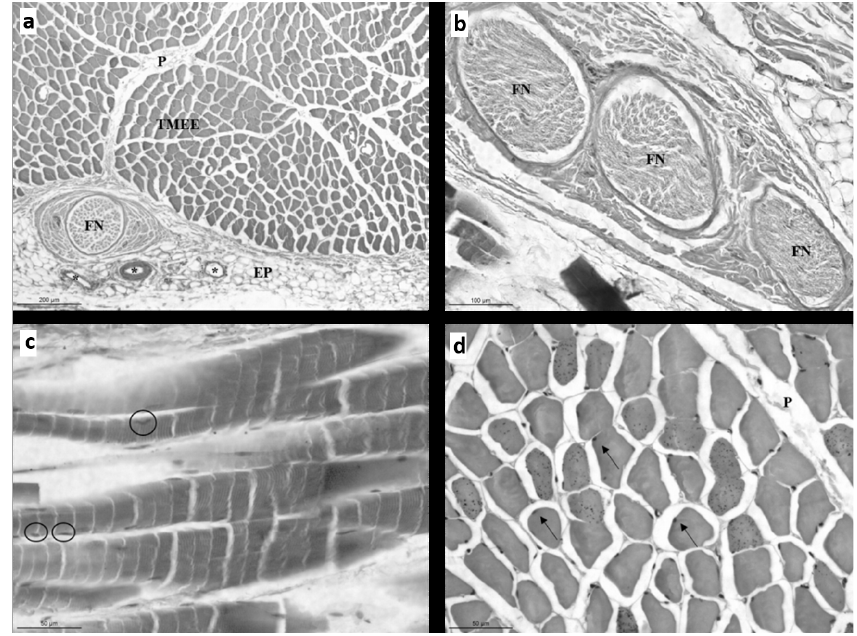
Figure 3 - Photomicroscopy of the diaphragm of Southern Tamandua. a: Overview of the organ composed by skeletal striated muscle tissue (TMEE) and covered by the epimysium (EP). Notice invaginations of connective tissue (P), portion of nervous bundle (FN) and vascularization (*). Gömöri trichrome stain. Scale bar 200 µm. b: nervous bundle (FN), composed of 3 nerve fibers. H&E stain. Scale bar 100 µm. c: Myocytes in longitudinal cut. Notice the stratifications and peripheral nucleus (circles). H&E stain. Scale bar 50 µm. d: Myocytes in transversal cut, covered by the endomysium (arrows). Gömöri trichrome stain. Scale bar 50